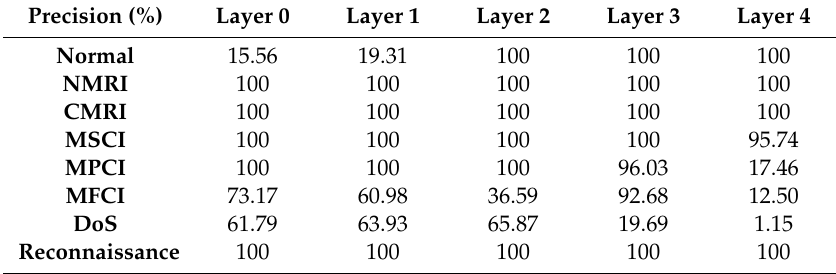
Table 1. Precision of the clustering results of each class in each hidden layer.